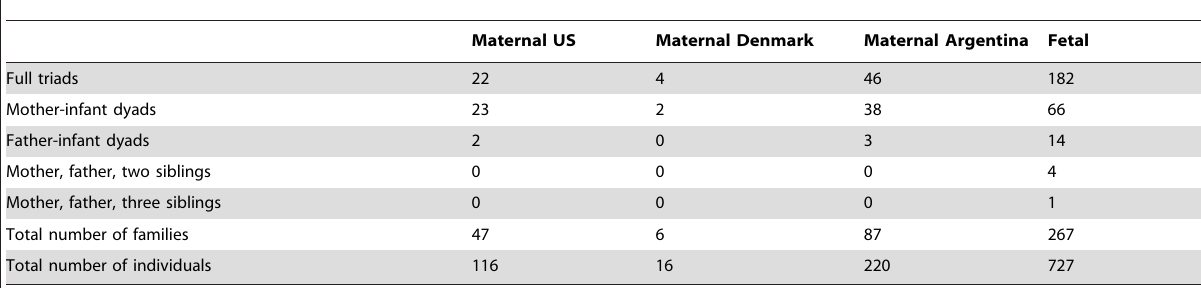
Table 2. Case families in the replication study.